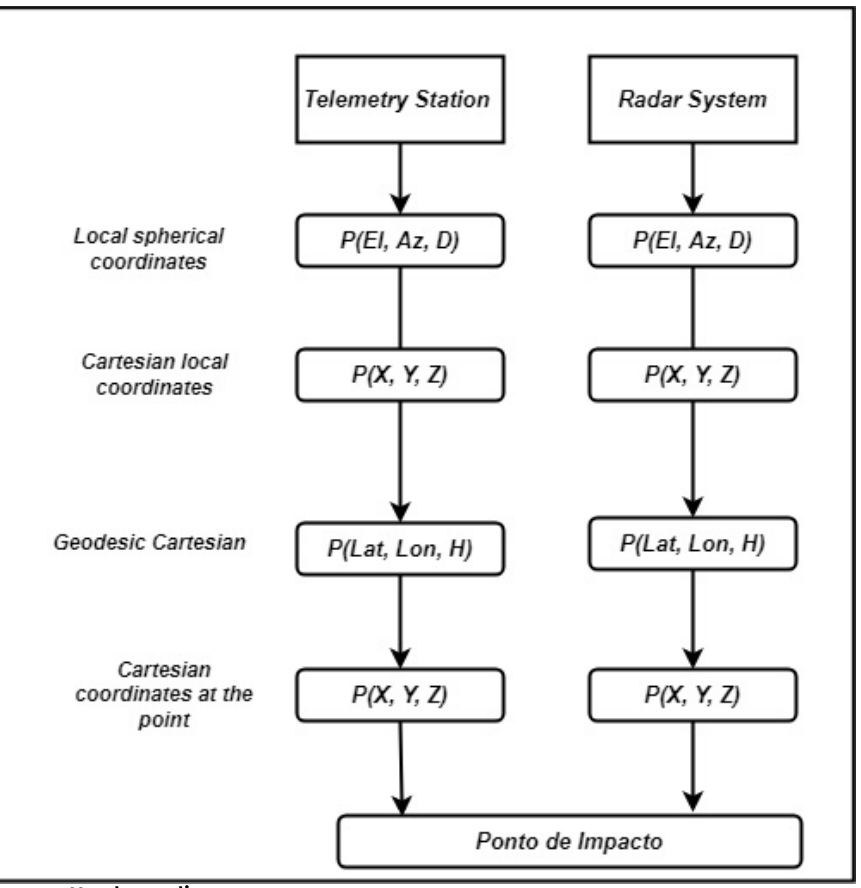
Figure 4. Used coordinate